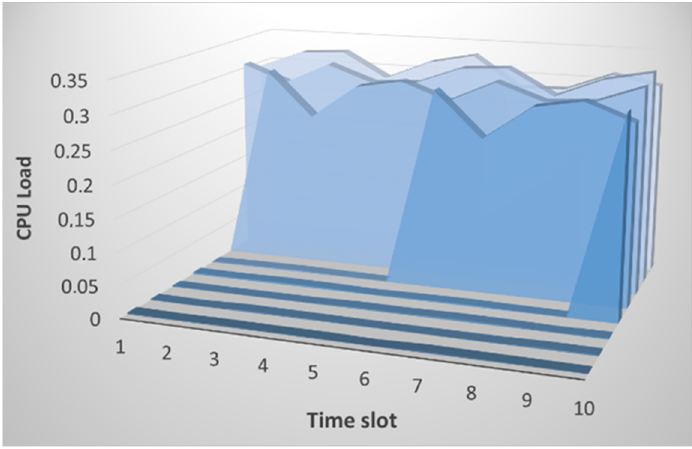
Figure 12. Changing the CPU load when analyzing raw data for node i under conditions of a SYN flood attack .